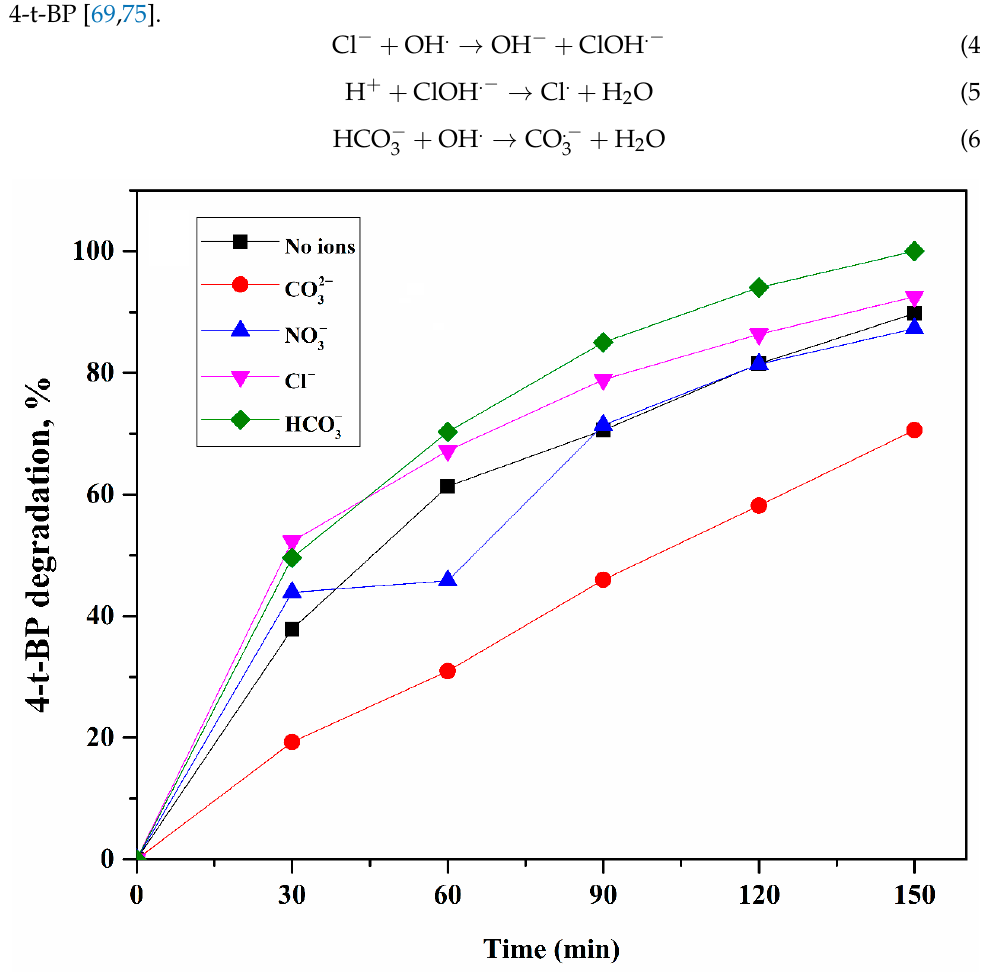
Figure 17. Effects of anions ( CO (cid:2871)(cid:2870)(cid:2879) ,NO (cid:2871)(cid:2879) ,Cl (cid:2879) and HCO (cid:2871)(cid:2879) ) on 4-t-BP degradation under solar light irradiation in the presence of mTiO-650. Reaction conditions: [4-t-BP] 0 = 5 mg/L, [photocatalyst] = 200 mg/L.